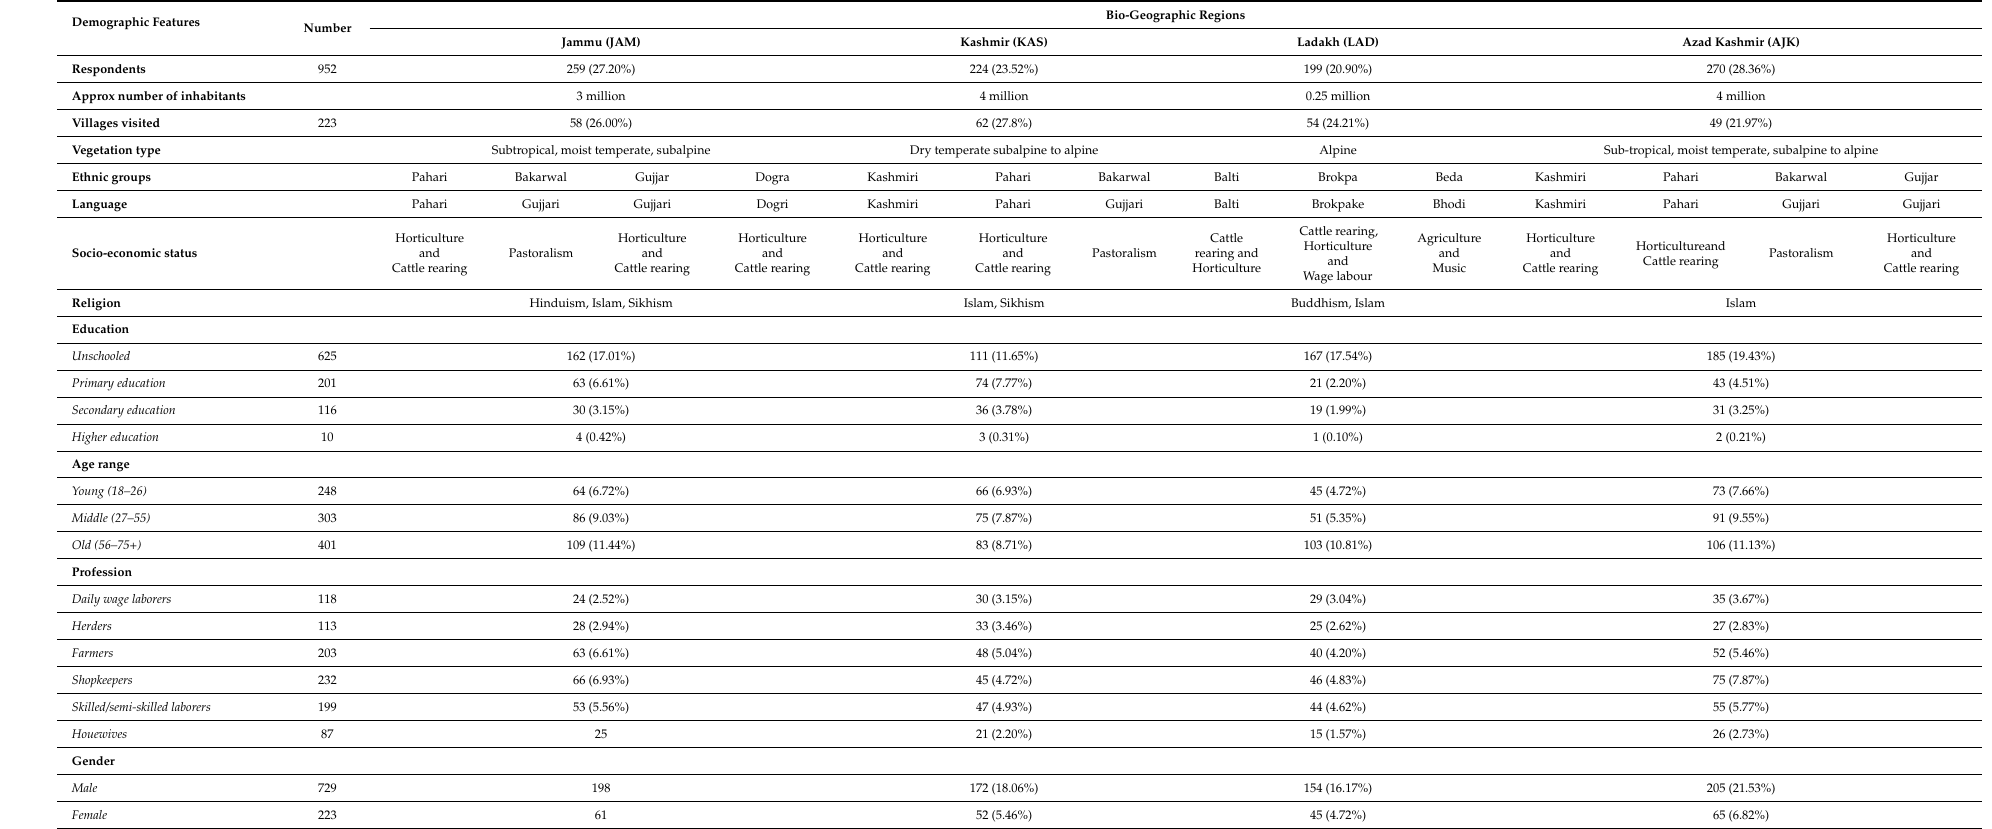
Table 1. Demographic status of the respondents from the study